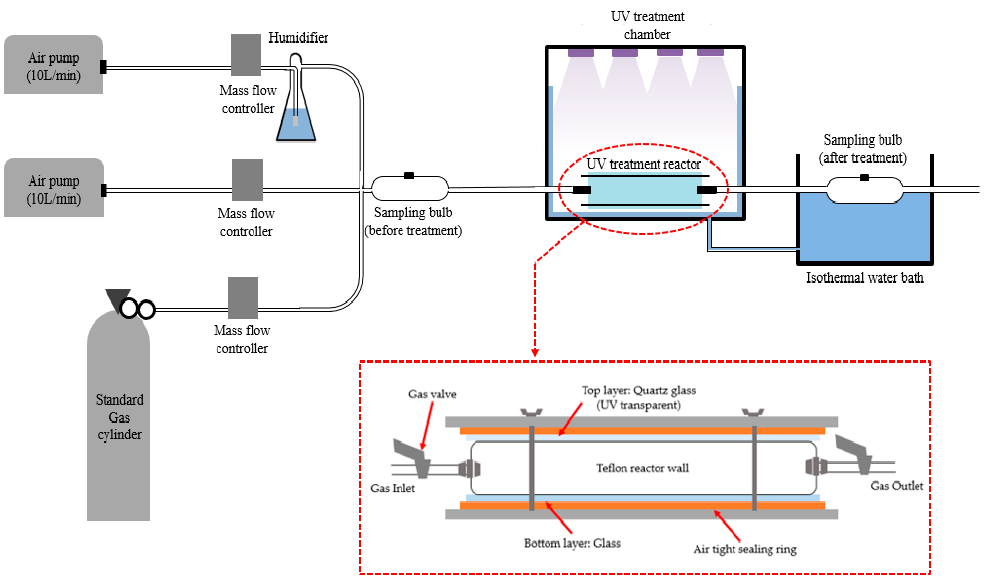
Figure 1. Schematic of UV-based mitigation of target gases at treatment times consistent with scaled-down conditions in the poultry barn.